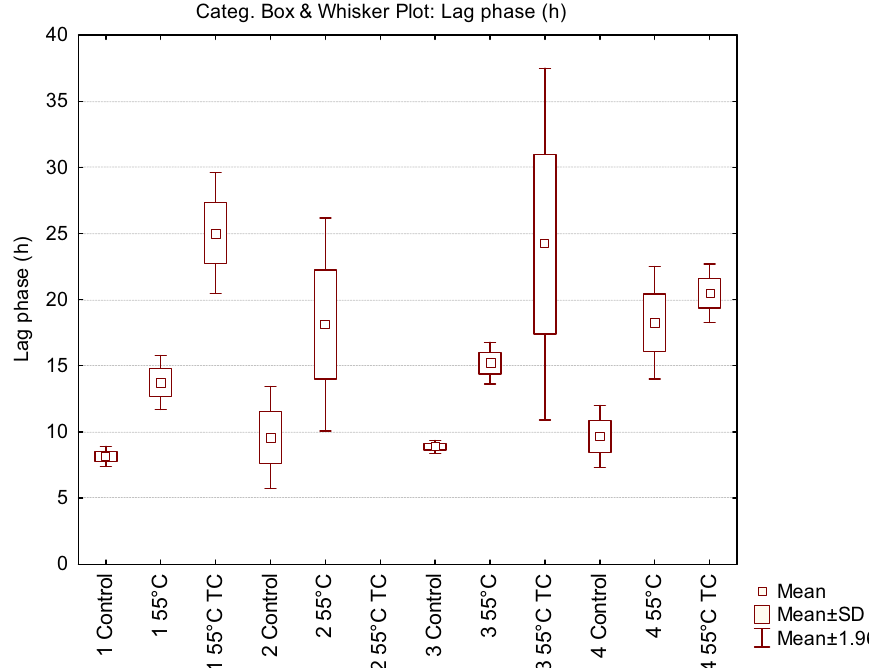
Figure 3. Box and Whisker plot describing the variability of lag phase (λ) in relation to the different cell origin and treatment. In the condition marked by an asterisk no growth was observed in any of the 28 replicates.